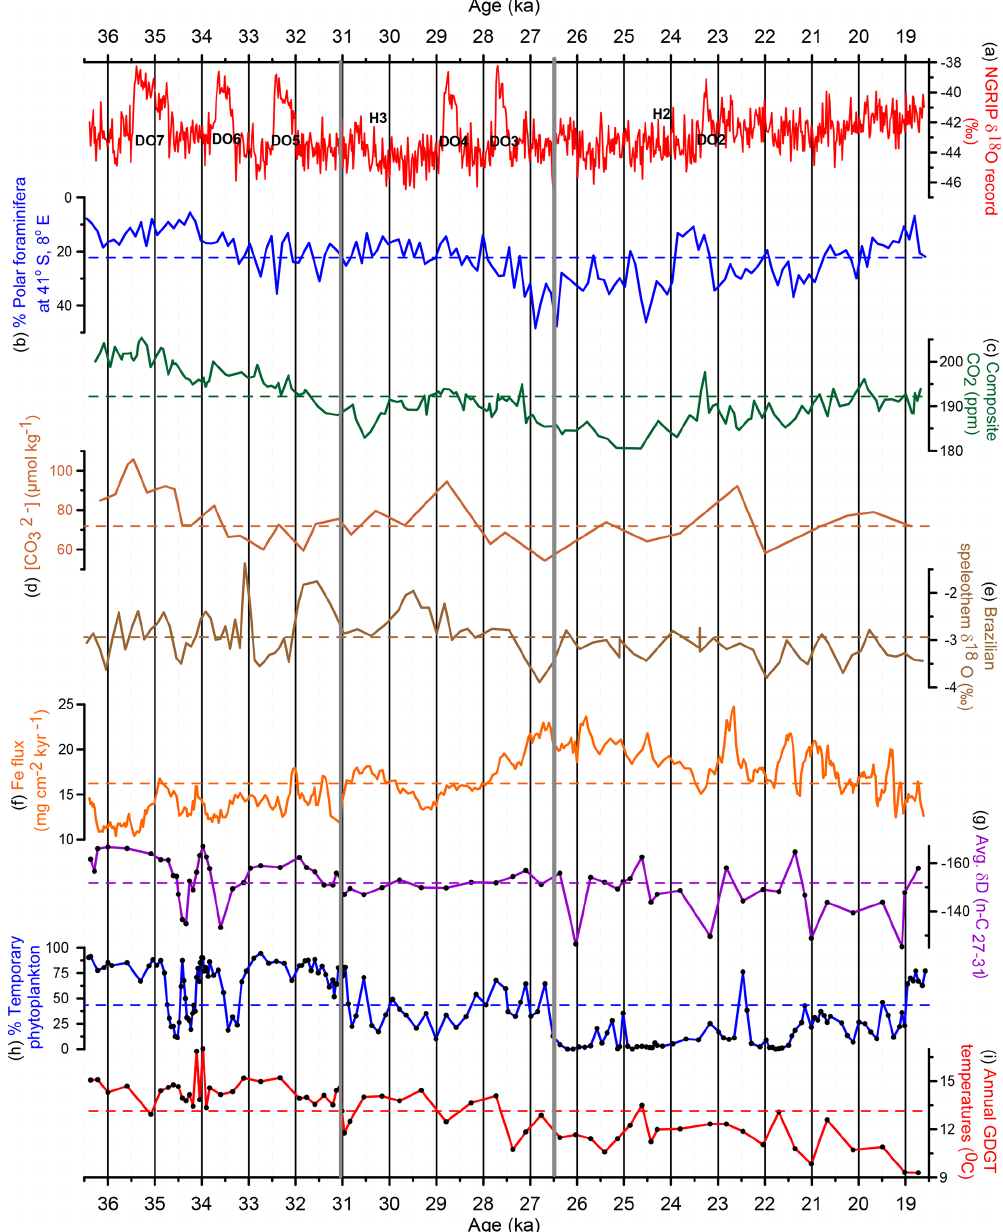
Figure 10. Comparisons between other proxy records (a–f) and Nightingale Island proxies for SHW (g) , wetness (h) and temperature (i) , with mean values as broken lines. (a) δ 18 O values from the North Greenland Ice core Project (NGRIP) ice core (Andersen et al., 2006) showing DO and H events. Ice core records are on a common timescale (Veres et al., 2013). (b) Abundance (%) of polar foraminifera at 41 ◦ S in the South Atlantic (Barker and Diz, 2014). (c) Composite Antarctic CO 2 record from Siple Dome (Ahn and Brook, 2014) and WAIS (Stenni et al., 2010). (d) (CO 2 − ) data at 44 ◦ S in the South Atlantic (Gottschalk et al., 2015). (e) Speleothem 18 O record on fluid inclusions 3 from SE Brazil (Millo et al., 2017). (f) Fe flux data in the South Atlantic at 42 ◦ S (Martínez-García et al., 2014). NI data are then followed. (g) Average δ D values for the terrestrial n -C 27 − 31 alkanes. (h) Abundance (%) of temporary phytoplanktonic diatoms implying relative water depth. (i) MAAT from the GDGT analyses. Note that sample levels are shown by a dot in (g) – (i) and that y axes of (b) and (g) show higher values downwards to facilitate comparisons to other proxies. Note that the two thick gray lines (31 and 26.5ka) indicate the position of the three PCA zones (Fig.